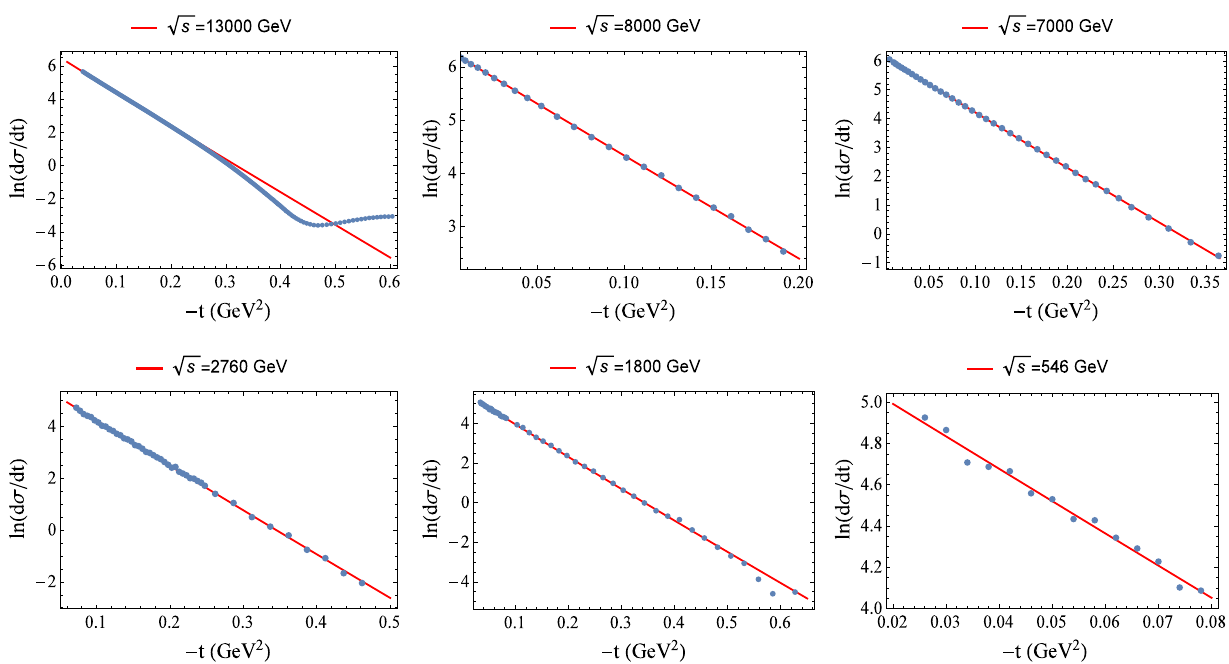
√ Fig. 3 The logarithmic fit of the pp , p ¯ p elastic collisions at s = 13000 , 8000 , 7000 , 2760 , 1800 , 546 GeV by the combination of the open and closed string pomeron. The fits are performed with data in the small ( − t ) region where linearity from single pomeron contribution is